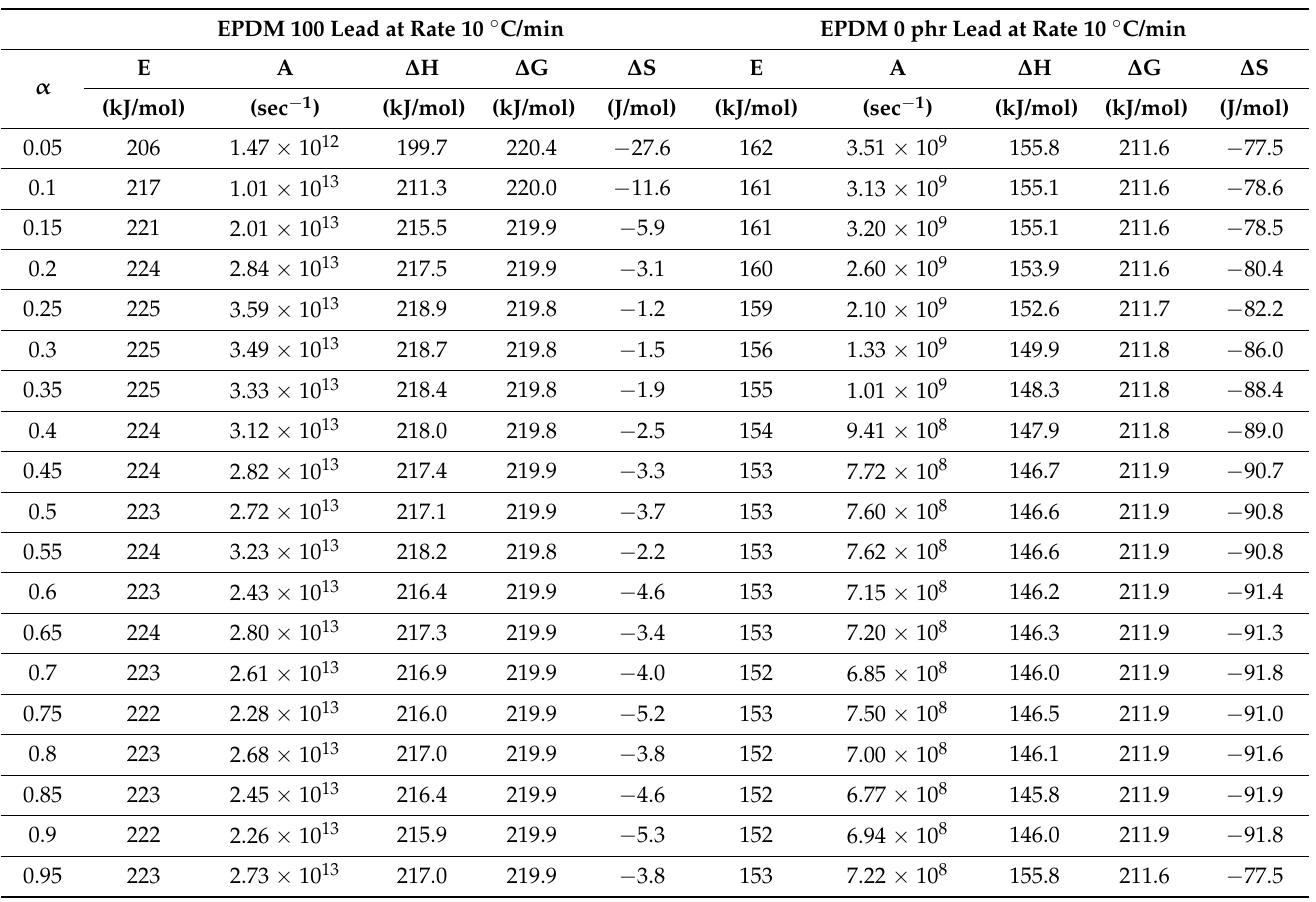
Table 7. The activation energy, pre-exponential factor, and thermodynamic parameters obtained using the KAS method at a 10 ◦ C/min heating rate for host and EPDM rubber loaded with 100 phr lead.